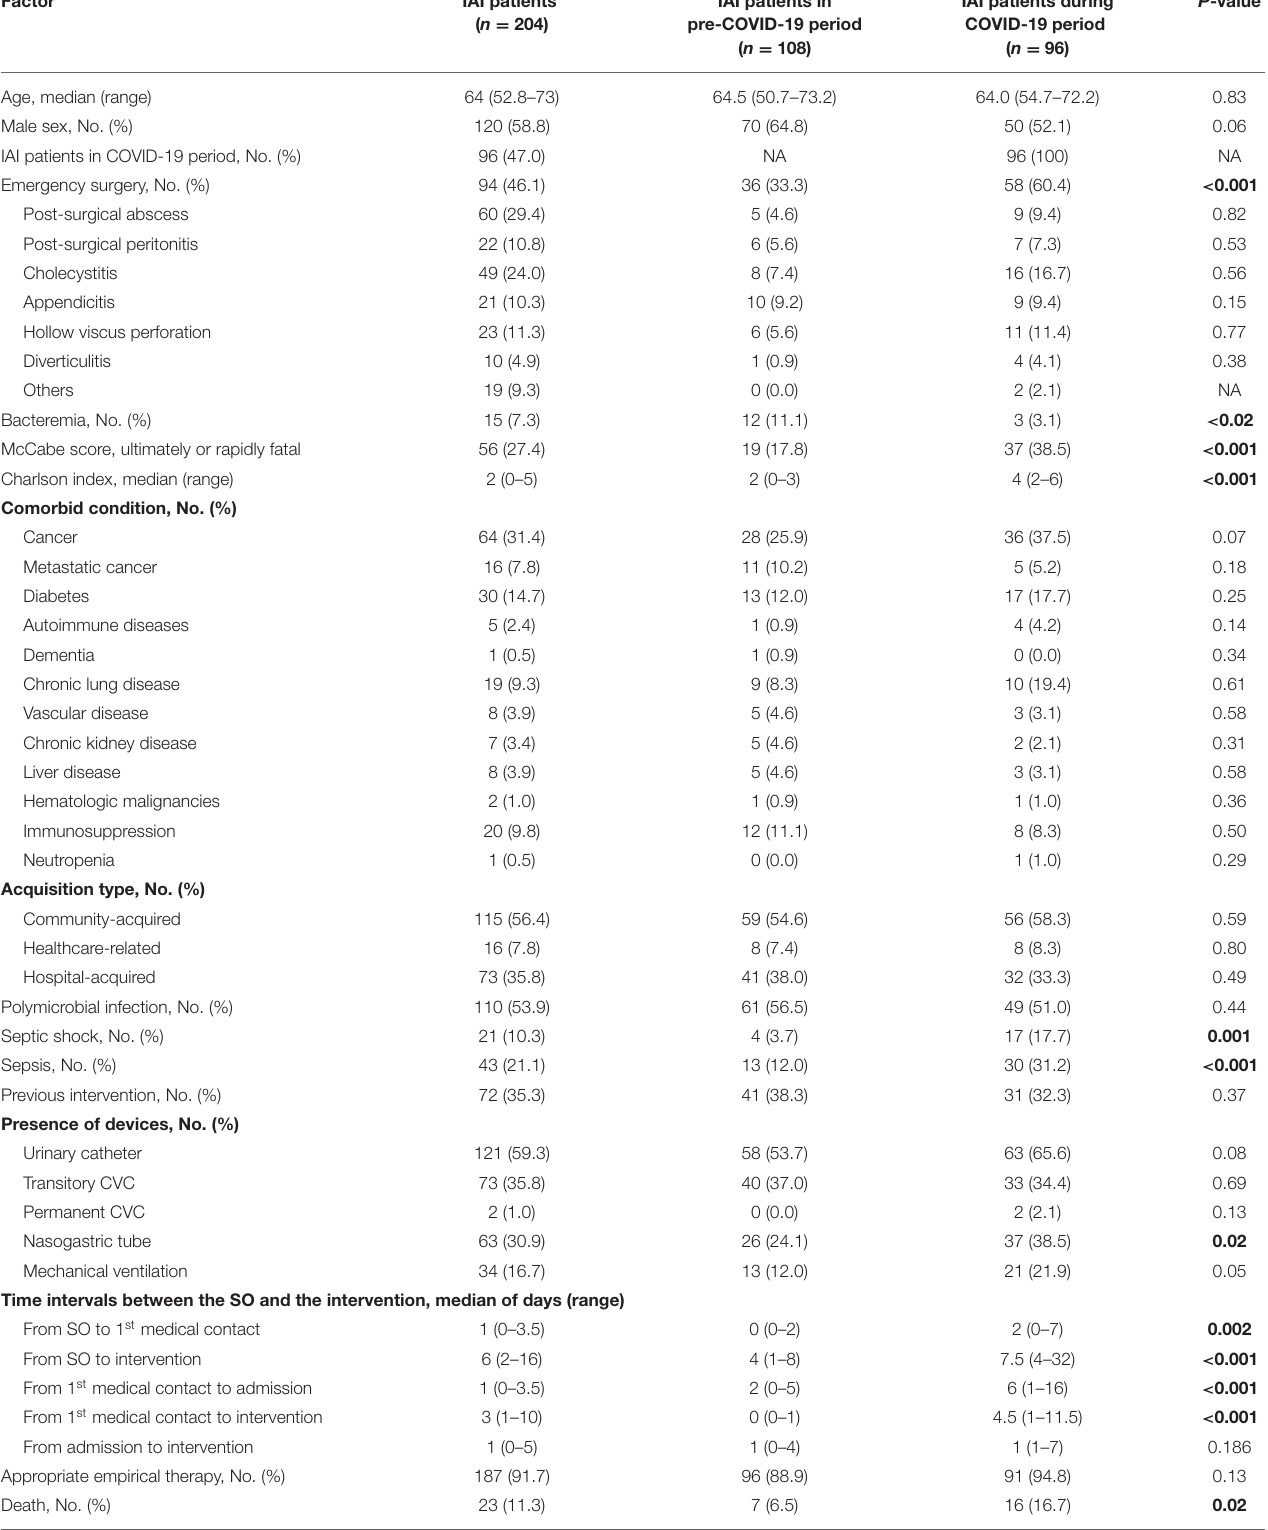
TABLE 1 | Demographics, clinical, and microbiological variables of the patients with IAI in the pre-COVID-19 pandemic period and during the COVID-19 pandemic period. Factor IAI patients